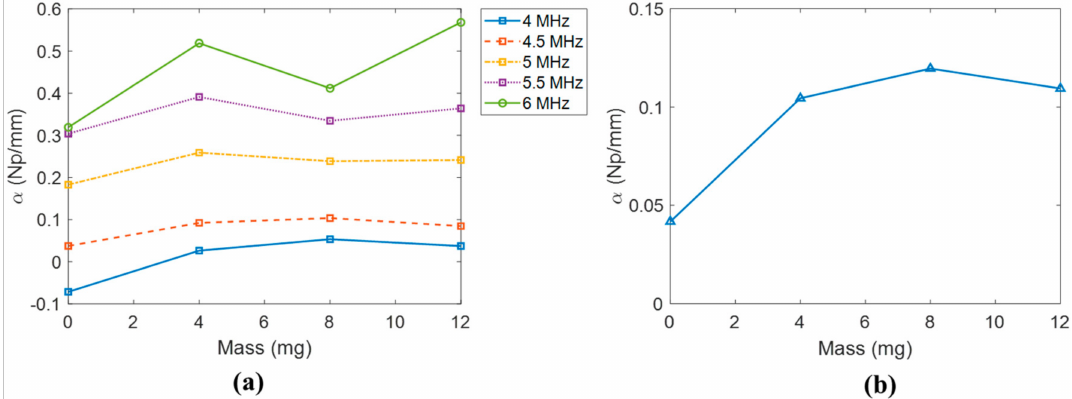
Figure 9. Coherent wave attenuation across a range of standard particle dosage: ( a ) at several frequencies, and ( b ) at averaged frequencies over a statistically valid